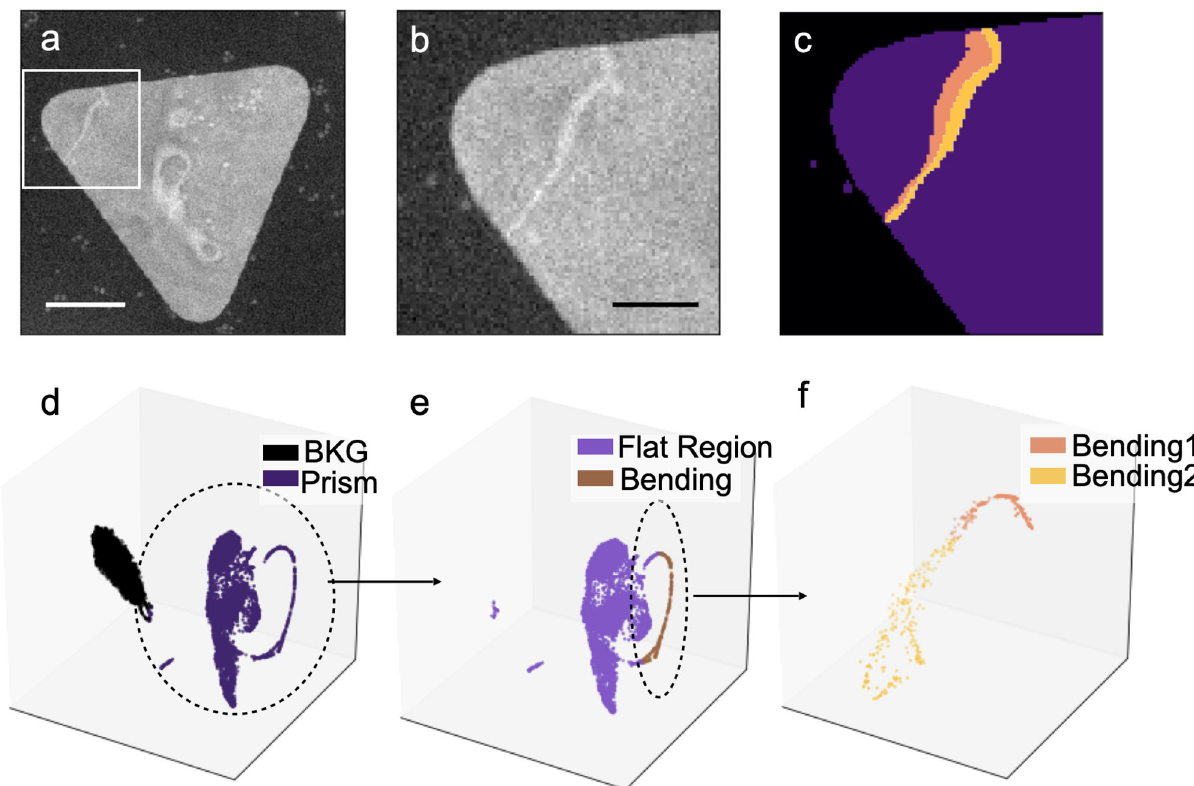
Fig. 4 Clustering results of silver nanoprisms. a ADF-STEM image of a silver nanoprism placed on amorphous SiN x supporting fi lm . Scale bar, 500 nm. b Zoomed-in ADF image from the white box in ( a ). Scale bar, 200 nm. c Real space map of the fi nal cluster and sub-cluster results. d – f Manifold structure of the data in each hierarchical clustering